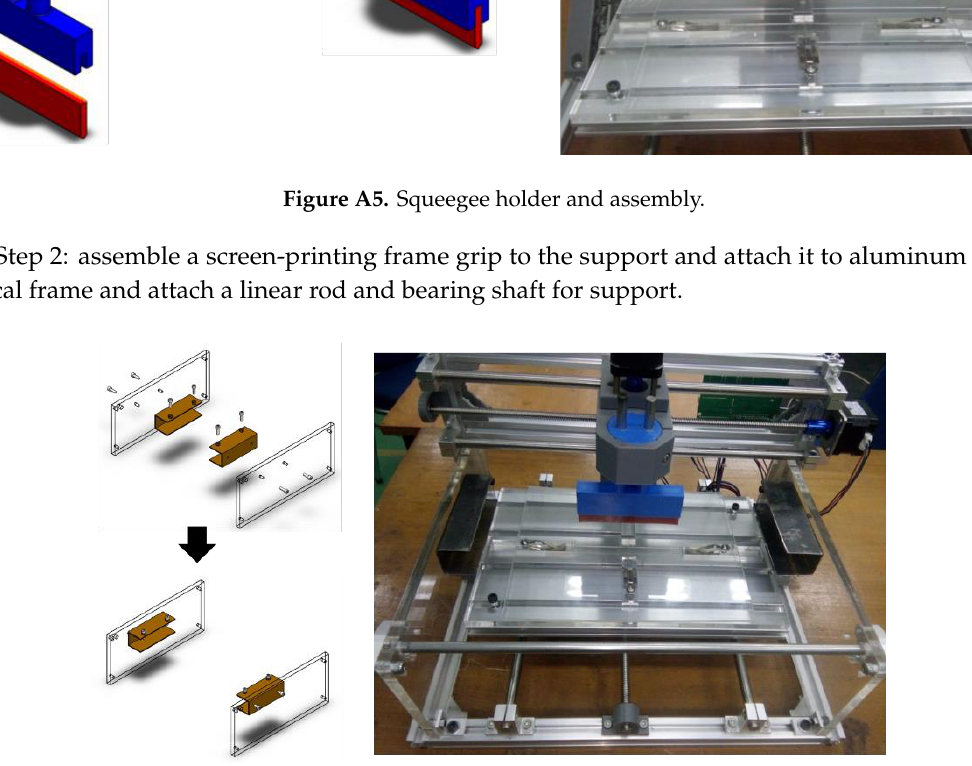
Figure A6. Vertical frames fitted on the existing computer numerical controlled (CNC) machine frame.